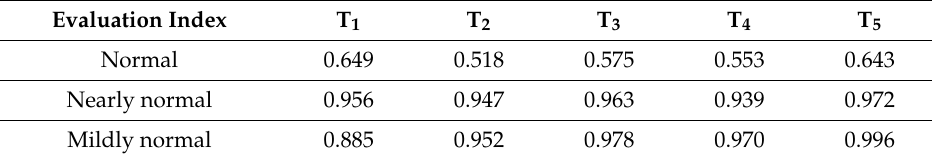
Table 7. The distance between IVIFSs and the positive ideal